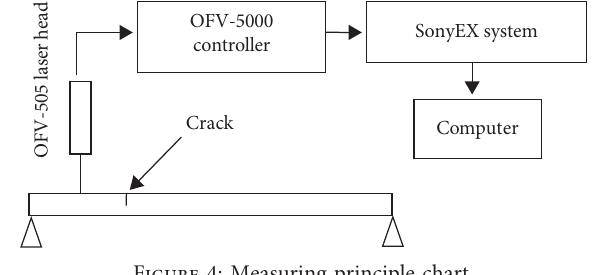
Figure 4: Measuring principle chart.